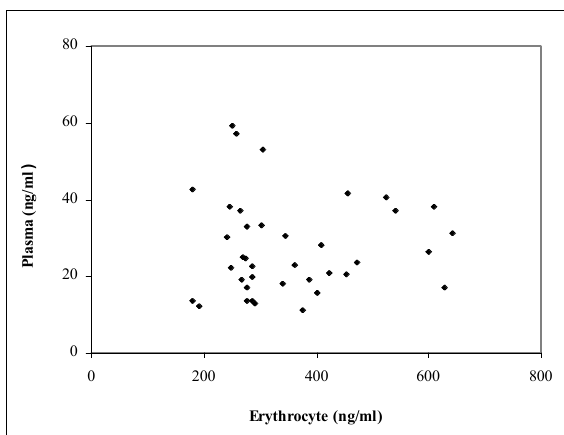
Figure 5. Scatter plot of eythrocyte and plasma folate concentrations.